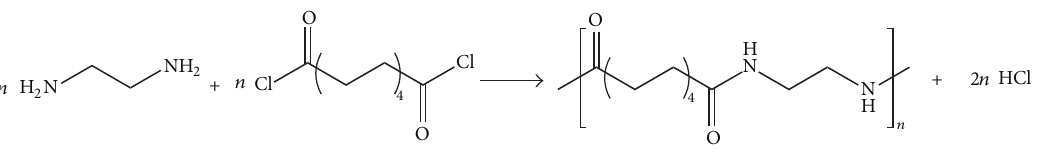
Figure 1: Scheme of the polymerization reaction.